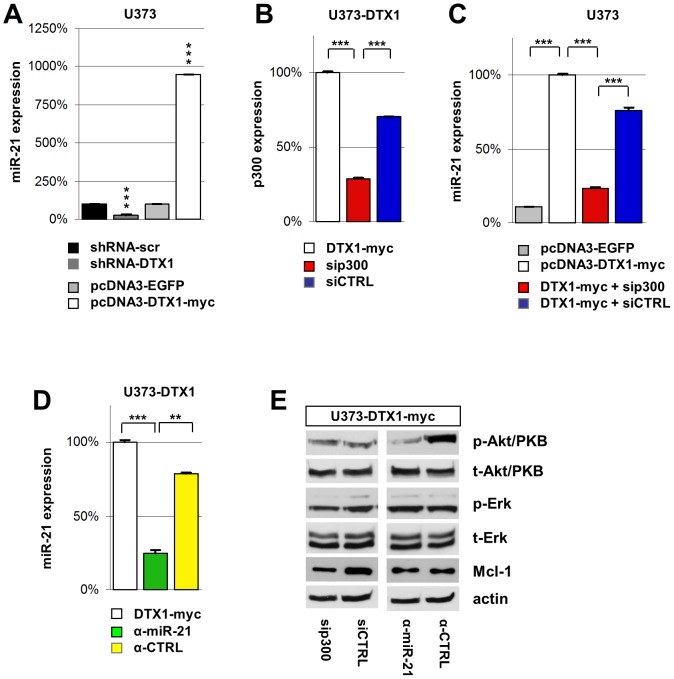
DTX1 controls miR-21 expression in a p300 dependent manner.(A) Real time quantitative PCR analysis of miR-21 expression in U373 cells with modified DTX1 levels. (B) p300 and (C) miR-21 expression levels in U373-DTX1-myc cells transfected with siRNA targeting p300 (sip300, red) or control siRNA (siCTRL, blue) analyzed by qPCR normalized to U373-DTX1-myc. (D) miR-21 expression in U373-DTX1-myc cells treated with miR-21 inhibitor (α-miR-21, green) or an inhibitor control (α-CTRL, yellow). Average relative expression values of at least four independent experiments are shown. Error bars: ±SEM. * p<0.05, ** p<0.01, *** p<0.001. (E) Western blot analysis of signaling cascades in U373-DTX1-myc cells transfected with sip300 or siCTRL. Blots were probed for phosphorylated and total Akt/PKB, phosphorylated and total Erk, Mcl-1 and actin.